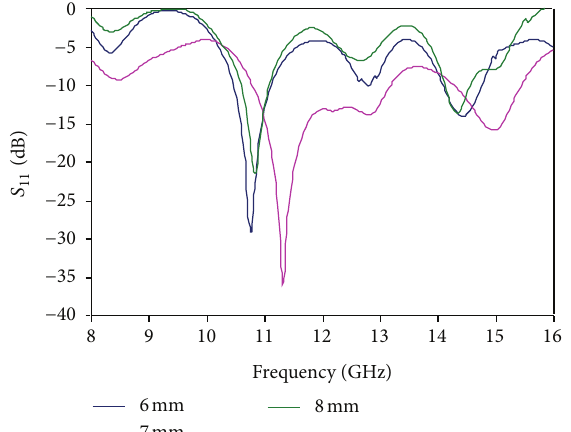
Figure 8: The photograph of anechoic chamber for prototype